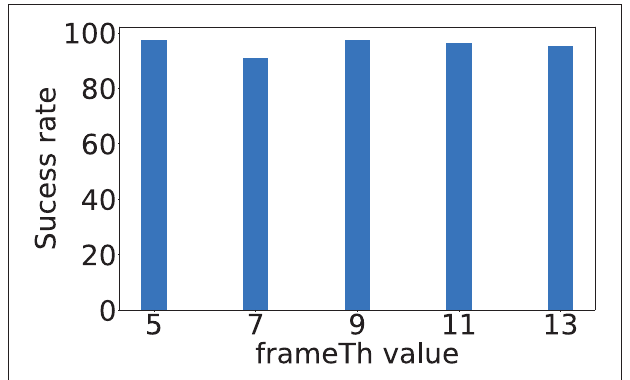
FIGURE 13 | Vision-based footstep event detection parameter frameTh and its impact on success rate.